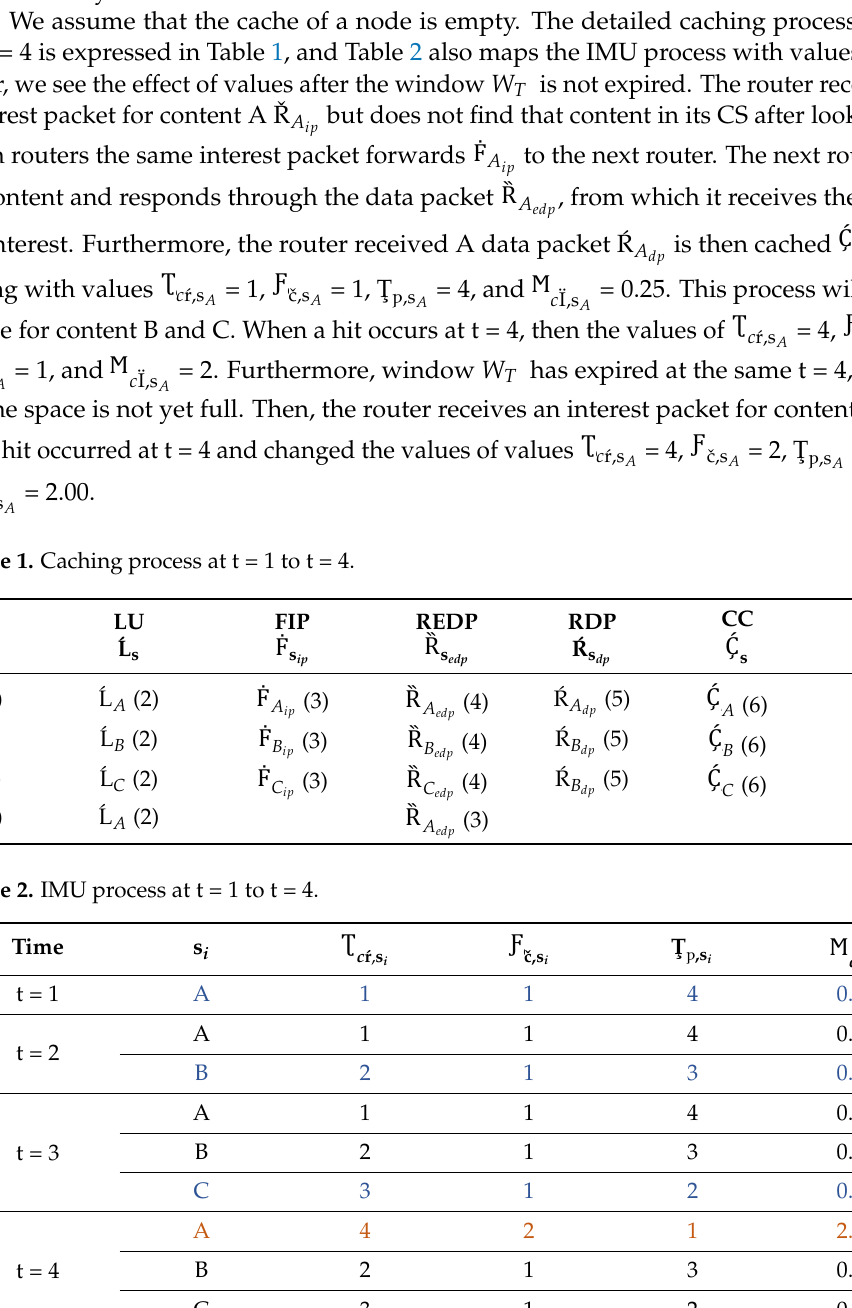
Algorithm 1: Determine the mature and immature content.